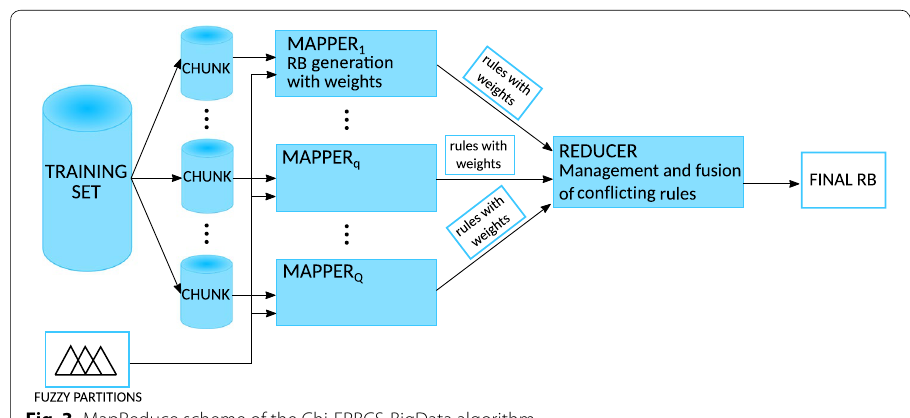
Fig. 3 MapReduce scheme of the Chi-FRBCS-BigData